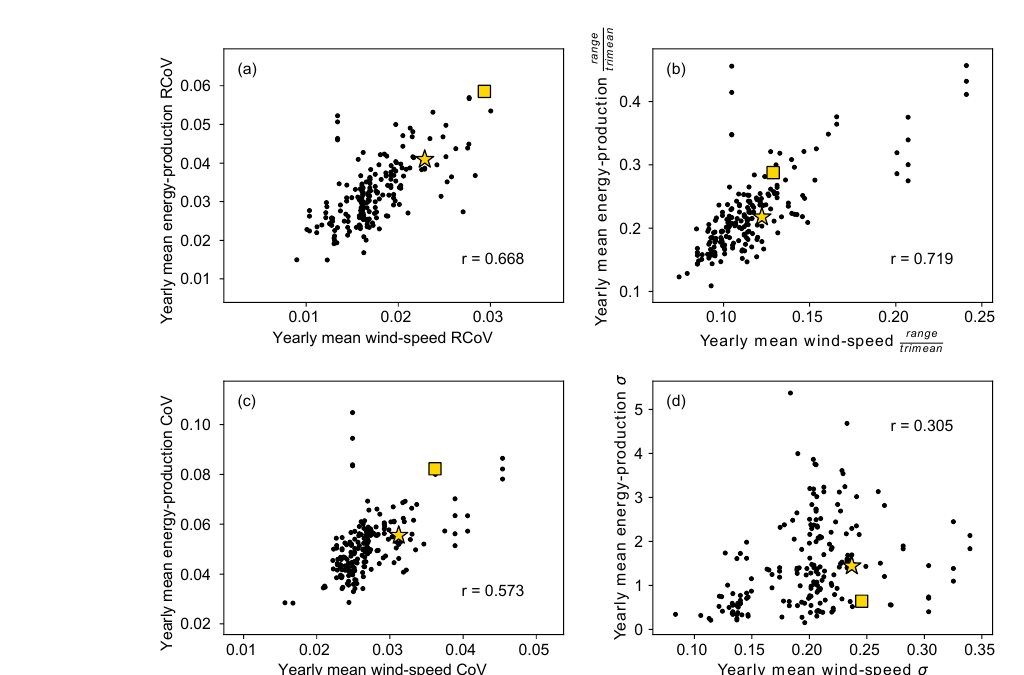
Figure A1. As in Fig. 4, but the metrics are calculated using annual-mean wind speed and energy production.